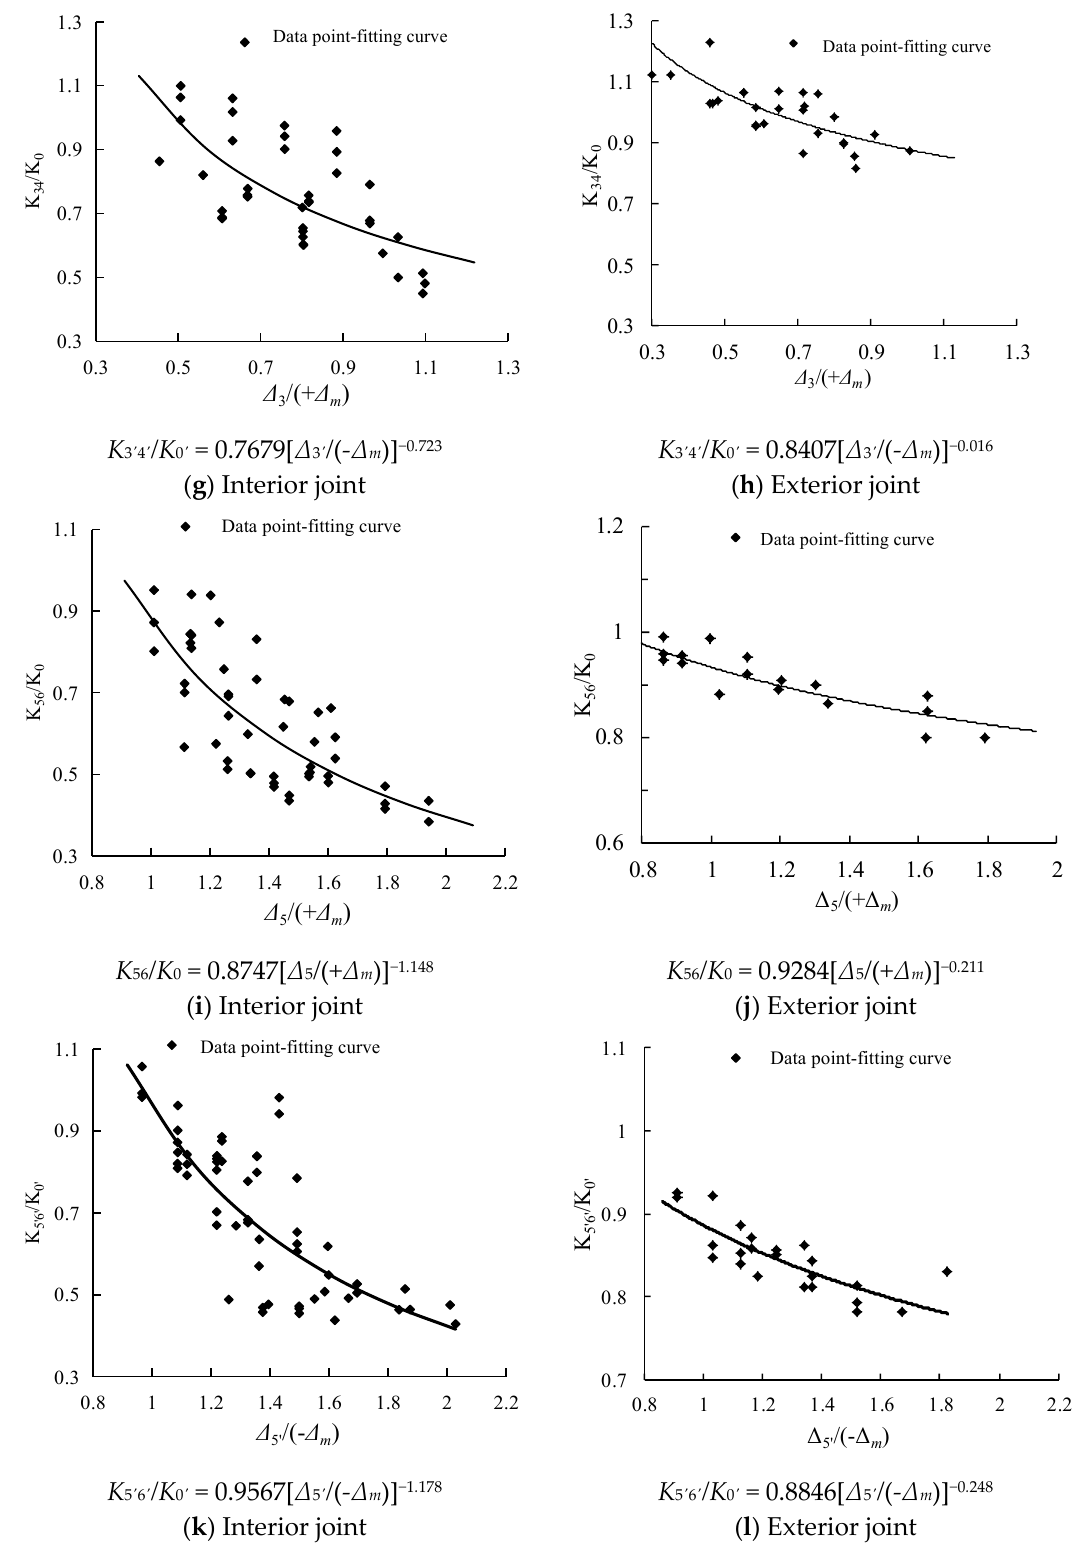
Figure 24. Stiffness degradation rule curve of unloading stiffness. Based on the experimental research, combined with the obtained hysteretic curve and skeleton curve, the restoring force model of composite joints proposed was shown in Fig- ure 25. The model considered the four stress stages of the composite joints during the whole loading process in the form of four broken lines, and fitted the stiffness degradation law of each stage, which can truly reflect the stiffness degradation law of the composite joints in each stress stage and was suitable for the elastic–plastic analysis of composite joints and other structures.